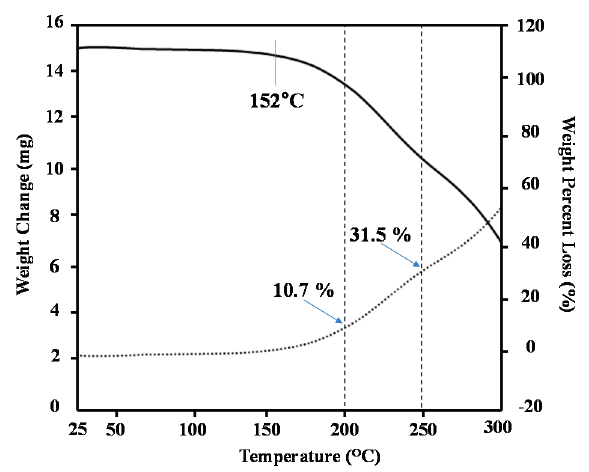
Figure 4. TGA of powder mixture of compounds 4 and 5 with a molar ratio = 1:1.